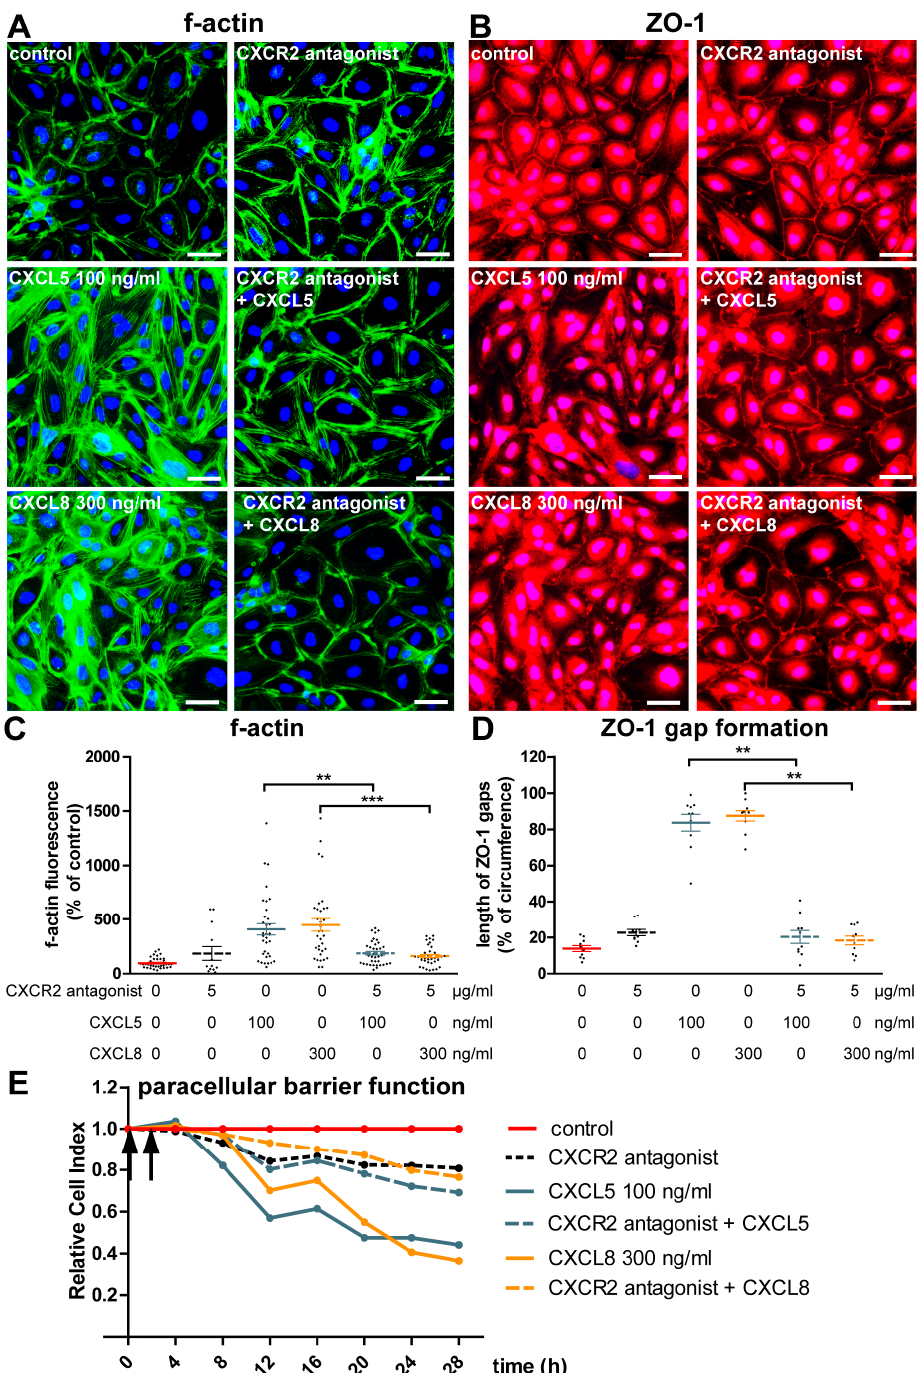
Figure 4. CXCL5 and CXCL8 induce actin stress fibers, downregulate ZO-1, and decrease paraendothelial barrier function via CXCR2. hCMEC/D3 monolayers were pre-incubated with 5 µM CXCR2 antagonist SB332235 or a corresponding concentration of dimethyl sulfoxide (DMSO) for 1 h and subsequently stimulated with CXCL5 or CXCL8 or left untreated for 30 min. ( A ) Visualization of filamentous actin by Alexa Fluor ® -conjugated phalloidin. ( B ) Immunofluorescent cytochemistry against the tight-junction-associated protein ZO-1. Scale bar = 25 µ m. ( C , D ) Quantification of relative filamentous actin fluorescence intensity (C) or formation of gaps in ZO-1 staining (D) after stimulation as in (A). Pooled from three to five independent experiments (Kruskal–Wallis test followed by Dunn’s post-test). ** p < 0.01; *** p < 0.001. For color coding see legend in figure panel (E). ( E ) Real-time monitoring of paracellular permeability after pre-incubation with the CXCR2 antagonist or DMSO control (arrow at the y-axis) for 1 h and subsequent stimulation with CXCL5 and CXCL8 (arrow on the right). Representative of three independent